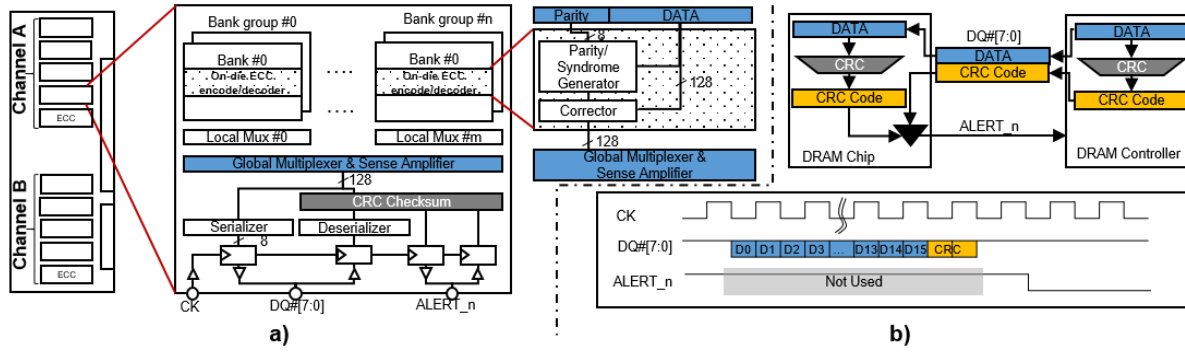
Figure 1. Summary of the background on the DRAM architecture and on-die ECC: ( a ) the hierarchical organization of DRAM and the position of the on-die ECC in the DRAM device and ( b ) a functional description of a ALERT_n